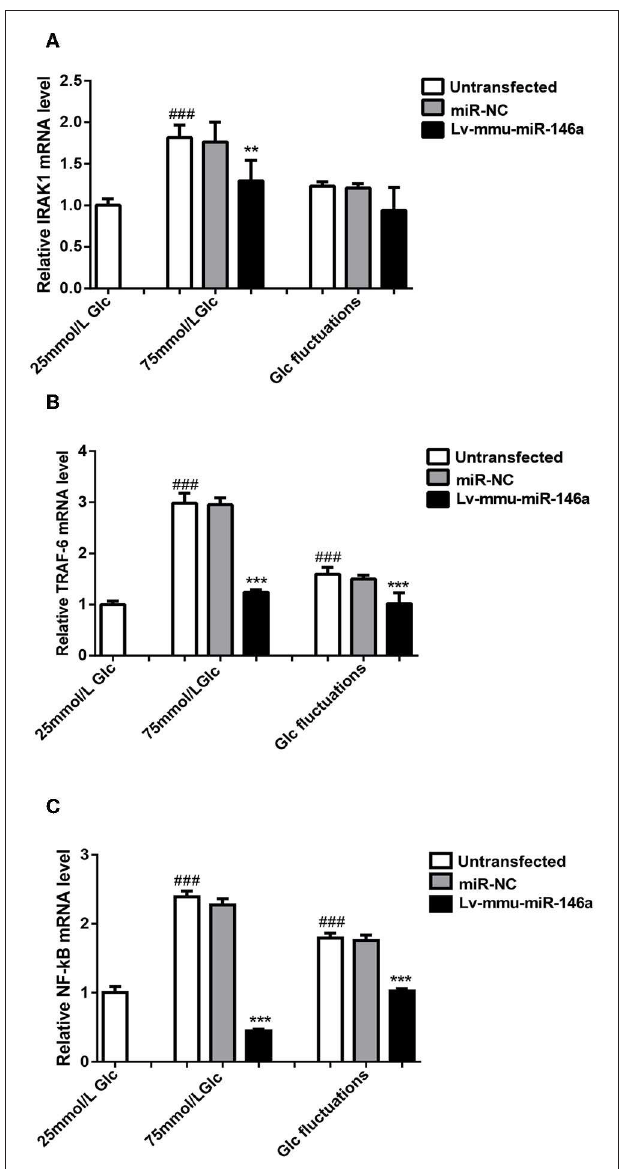
FIGURE 6 | miR-146a regulation of polarization transitions via the IRAK1/TRAF6/NF- κ B signaling pathway. (A) IRAK1 mRNA expression levels. ### p < 0.001, 75 mmol/L Glc vs. control; ** p < 0.01, 75 mmol/L Glc + Lv-mmu-miR-146a group vs. 75 mmol/L Glc group. (B) TRAF6 mRNA expression levels. ### p < 0.001, 75 mmol/L Glc vs. control, Glc fluctuation group vs. control; *** p < 0.001, 75 mmol/L Glc+Lv-mmu-miR-146a group vs. 75 mmol/L Glc group, Glc fluctuation + Lv-mmu-miR-146a group vs. Glc fluctuation group. (C) NF- κ B mRNA expression levels. ### p < 0.001, 75 mmol/L Glc vs. control, Glc fluctuation group vs. control; *** p < 0.001, 75 mmol/L Glc + Lv-mmu-miR-146a group vs. 75 mmol/L Glc group, Glc fluctuation + Lv-mmu-miR-146a group vs. Glc fluctuation